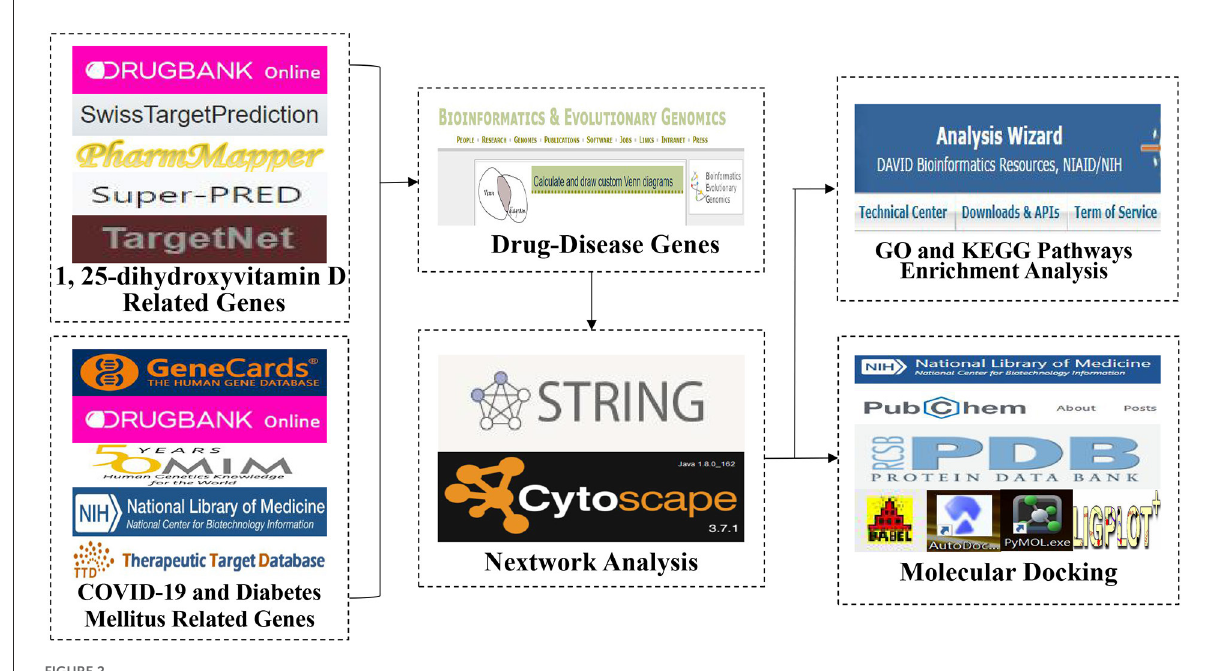
FIGURE2 The flow-process diagram of the